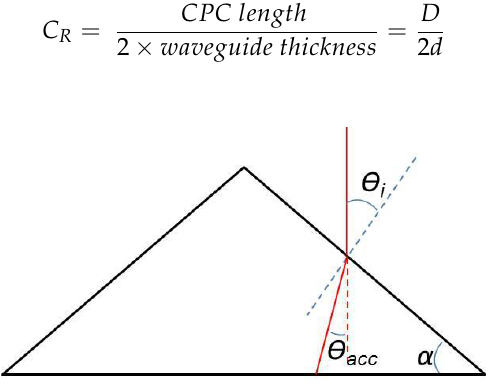
Figure 4. The relationship between the prism structure and the acceptance angle of the CPC.